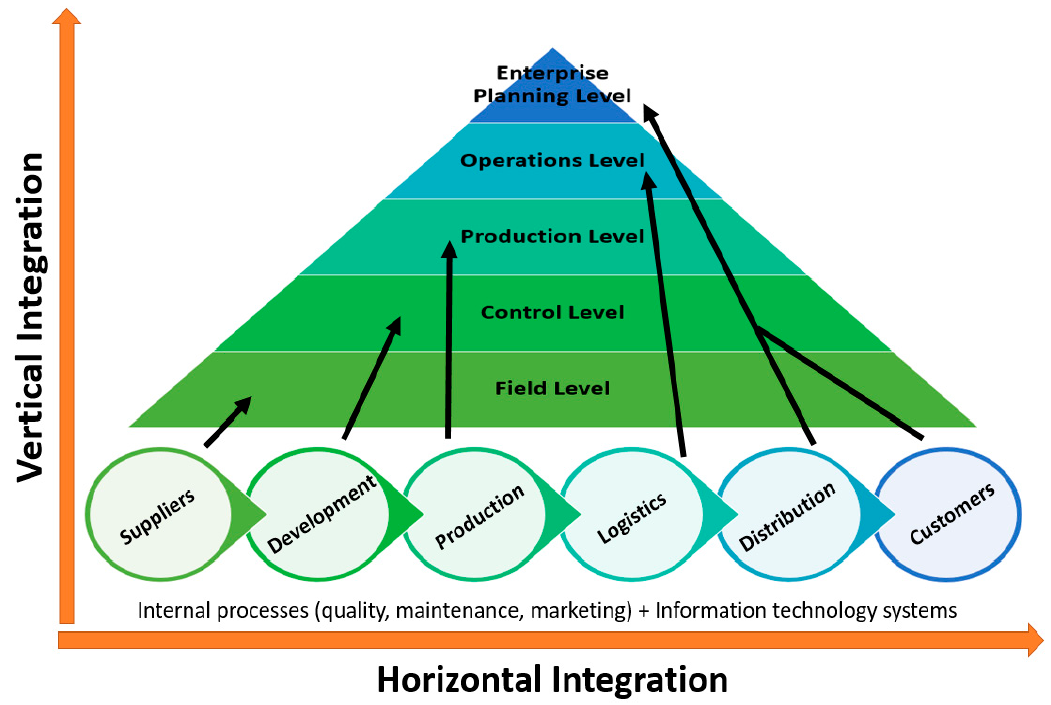
Figure 8. Horizontal and vertical integration models.